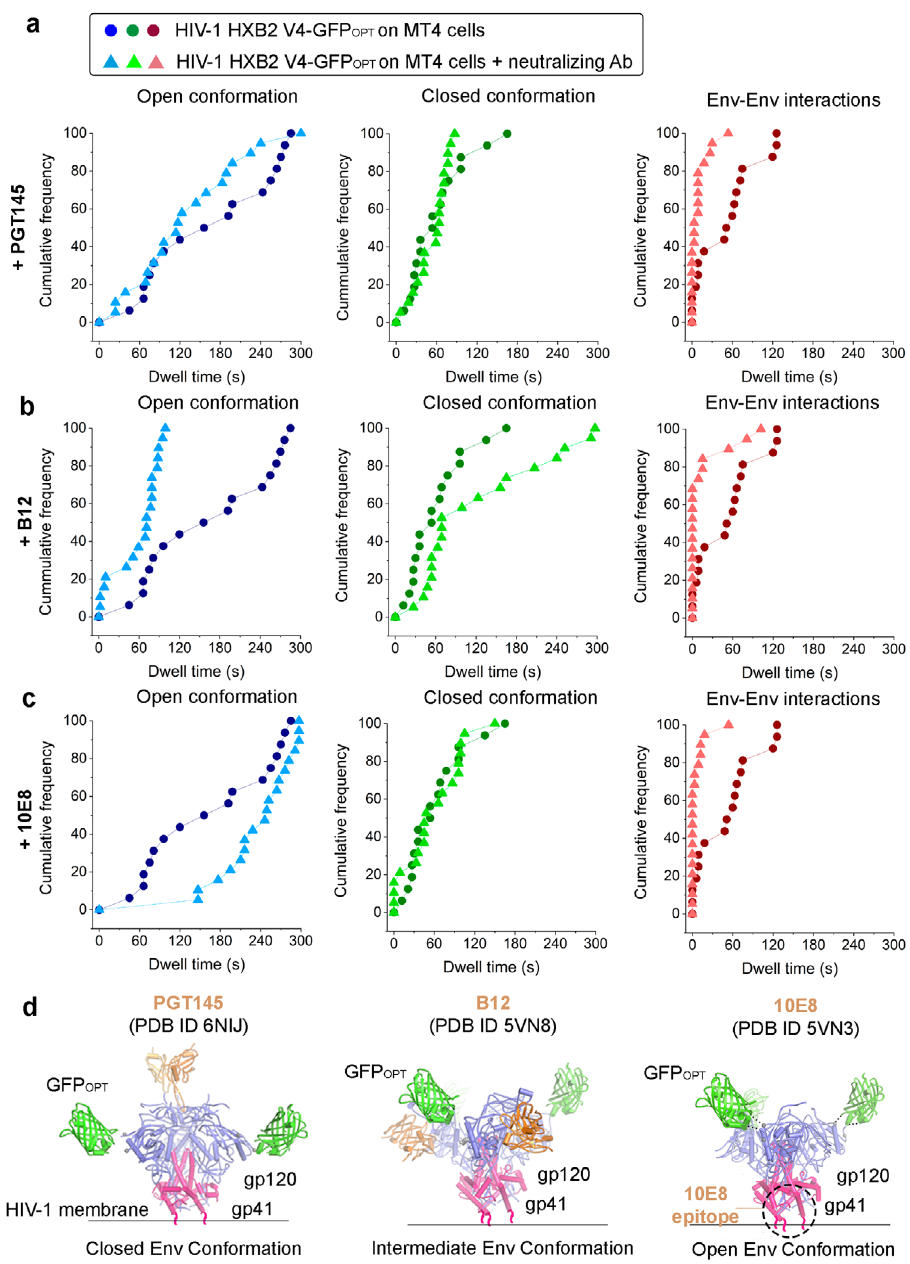
Fig. 4 HIV-1 Env association is destabilized when exposing virions to neutralizing antibodies in live T cells. Cumulative Distribution Functions (CDF) are plotted for FRET ef fi ciency traces obtained from at least (n = 20) HIV-1 HXB2 V4-GFP OPT virions in presence of living T cells without (solid dots) or with (solid triangles) neutralizing antibodies PGT145 ( a ), b12 ( b ), and 10E8 ( c ). Each FRET regime (high, E app >0.23 in red; intermediate, 0.12<E app <0.23, in green; low , E app <0.12, in blue) determines the Env conformational state/distribution and kinetics. d The HIV-1 Env structures representing closed Env associated with PGT145 (PBD ID 6NIJ, left), b12 (PBD ID 5VN8, middle) or 10E8 (PBD ID 5VN3, right) were modi fi ed to illustrate the labelling of the V4 loop with GFP OPT